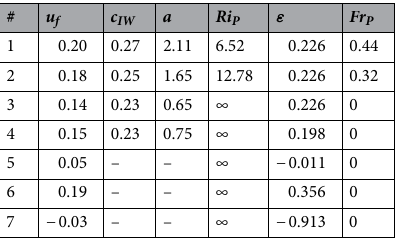
Table 2. Summary table (in S.I.) from numerical results.